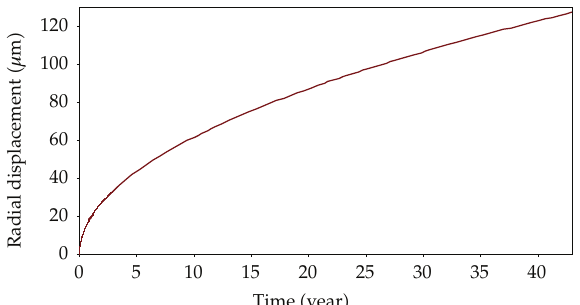
Figure 4: Radial displacement at rebar surface with time t .